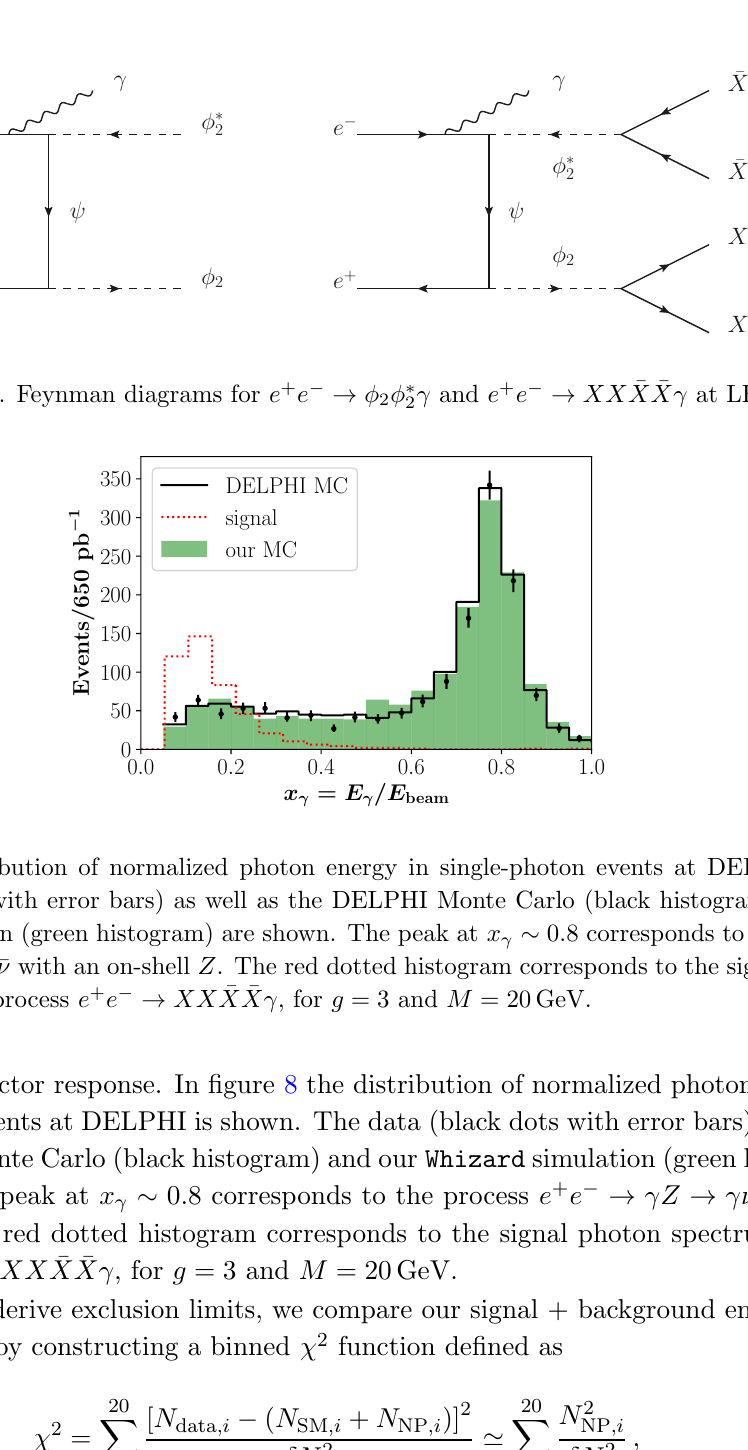
Figure 7 . Feynman diagrams for e + e (cid:0)